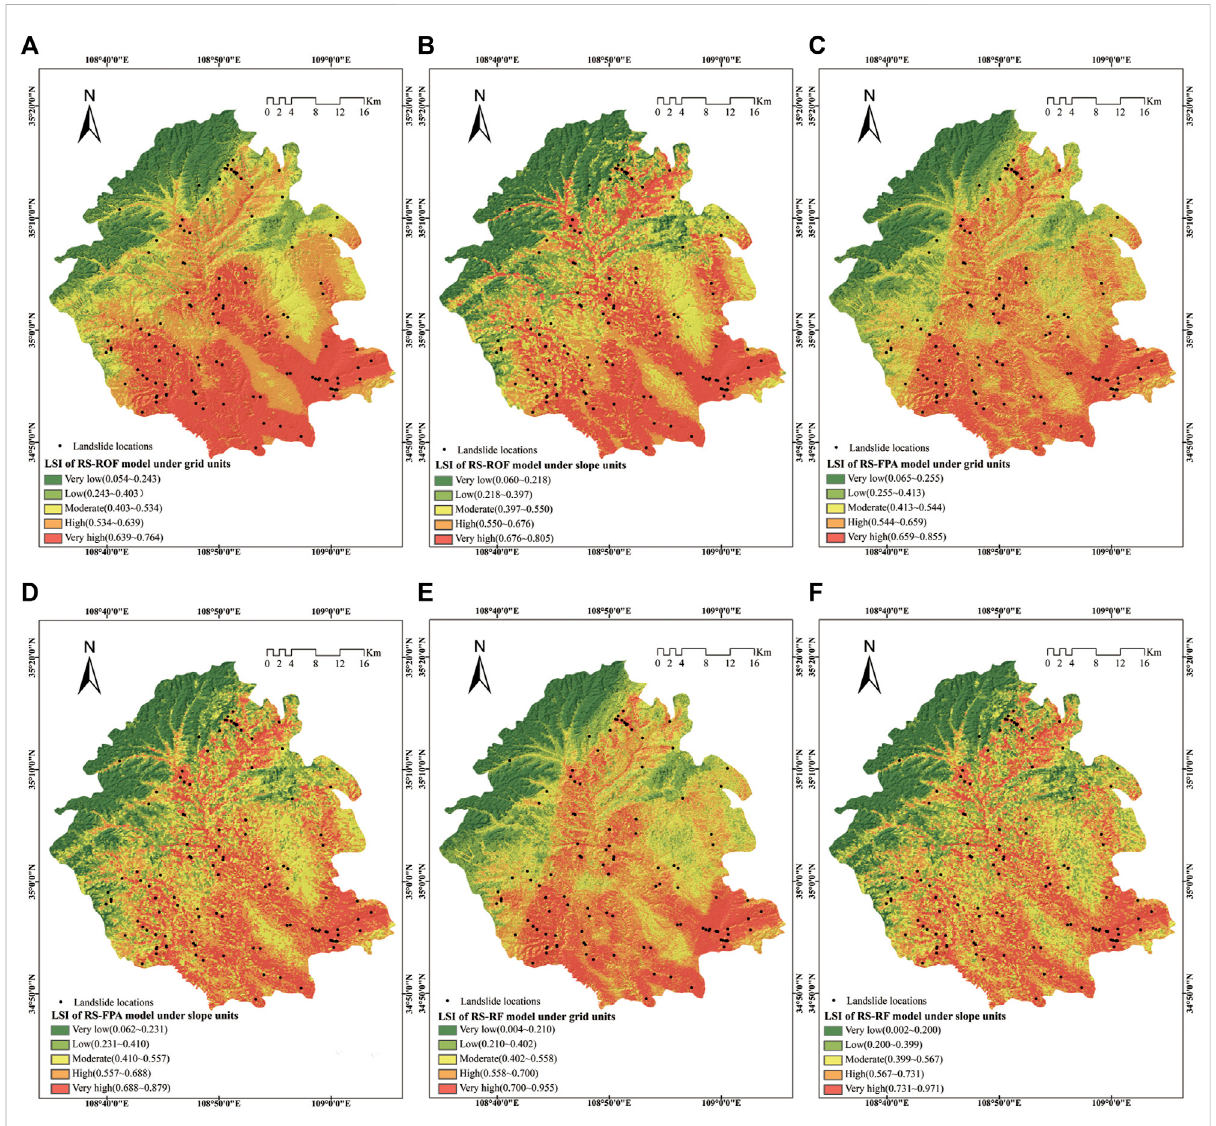
FIGURE 7 Landslide susceptibility maps using three models of different units: (A) LSI of RS-ROF model under grid units; (B) LSI of RS-ROF model under slopeunits; (C) LSIofRS-FPAmodelundergridunits; (D) LSIofRS-FPAmodelunderslopeunits; (E) LSIofRS-RFmodelundergridunits; (F) LSIofRS- RF model under slope